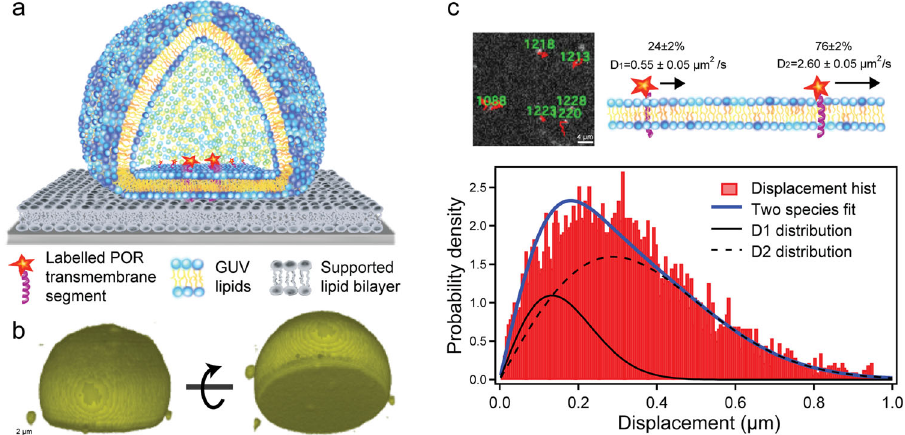
Fig. 2 Reconstitution of POR transmembrane anchor segment in a fl uid lipid membrane system. a Synthesized fl uorescently labeled anchors are reconstituted in Giant Unilamellar Vesicles (GUVs) gravitationally settled on a supported lipid bilayer. b Three-dimensional reconstruction of a fl uorescently labeled GUV based on confocal microscopy. c Single molecule tracking by Total Internal Re fl ection Fluorescence (TIRF) microscopy of anchors diffusing in GUV membrane interfaced with a supported bilayer. Single molecule displacement data were fi tted with a free Brownian diffusion model (blue trace on graph) yielding two diffusing species with diffusion coef fi cients and weights as indicated. The errors indicate the 95% Highest Density Interval (HDI) of the posterior probability distribution for the diffusion coef fi cients ( fi ts were based on 11,444 displacement, time pairs collected from tracking experiments with n = 3 different GUVs from two independent samples. The histogram show displacements for a fi xed 16 ms time lapse (6,355 data points) - see Supplementary Table 1 for additional information including POR-488 data). Source data are available in Supplementary Data 5. COMMUNICATIONS BIOLOGY| (2021) 4:1057